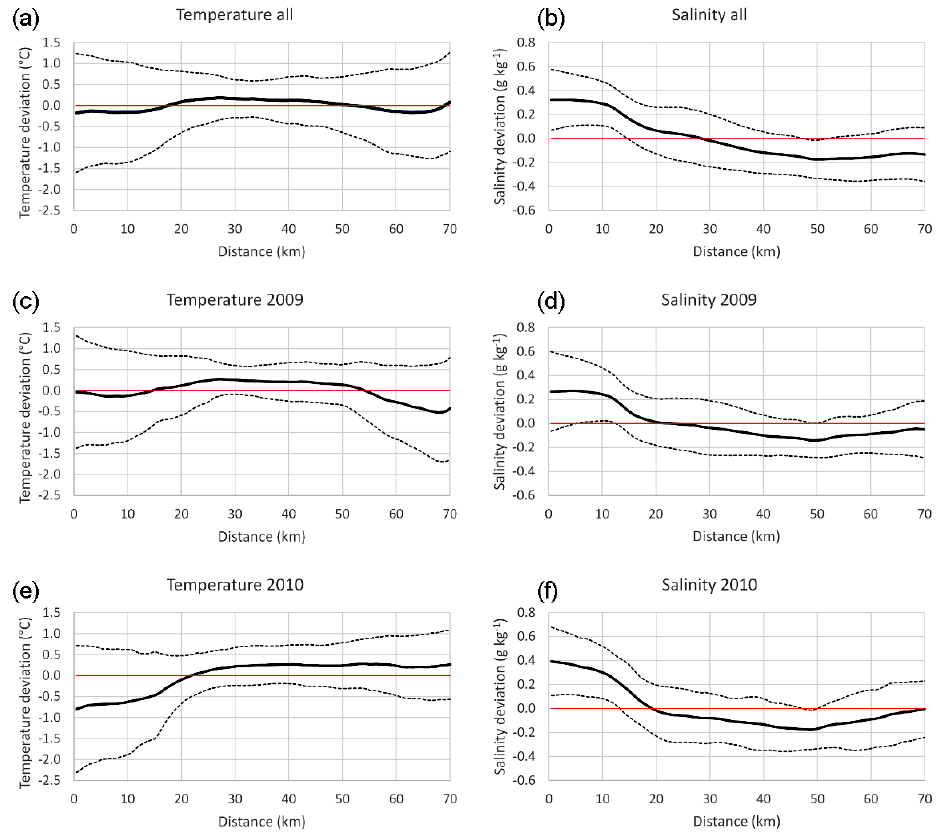
Figure 3. Distributions of temperature (in ◦ C) and salinity (in gkg − 1 ) deviations from the transect mean value along the Tallinn–Helsinki ferry route for all measurements in May–September 2007–2013 (a, b) , 2009 (c, d) and 2010 (e, f) . Mean values for each 0.5km cell (solid curves) and plus/minus RMSE (dashed curves) are shown; x axis indicates the distance from Tallinn Bay (latitude 59.48N) in km along the meridional